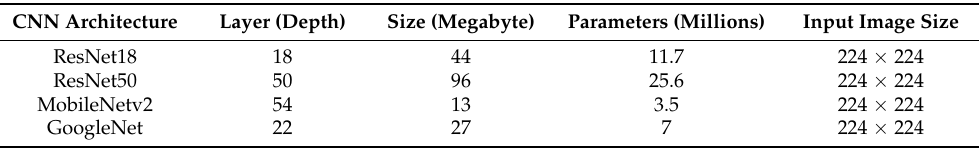
Table 3. Properties of pre-trained CNN